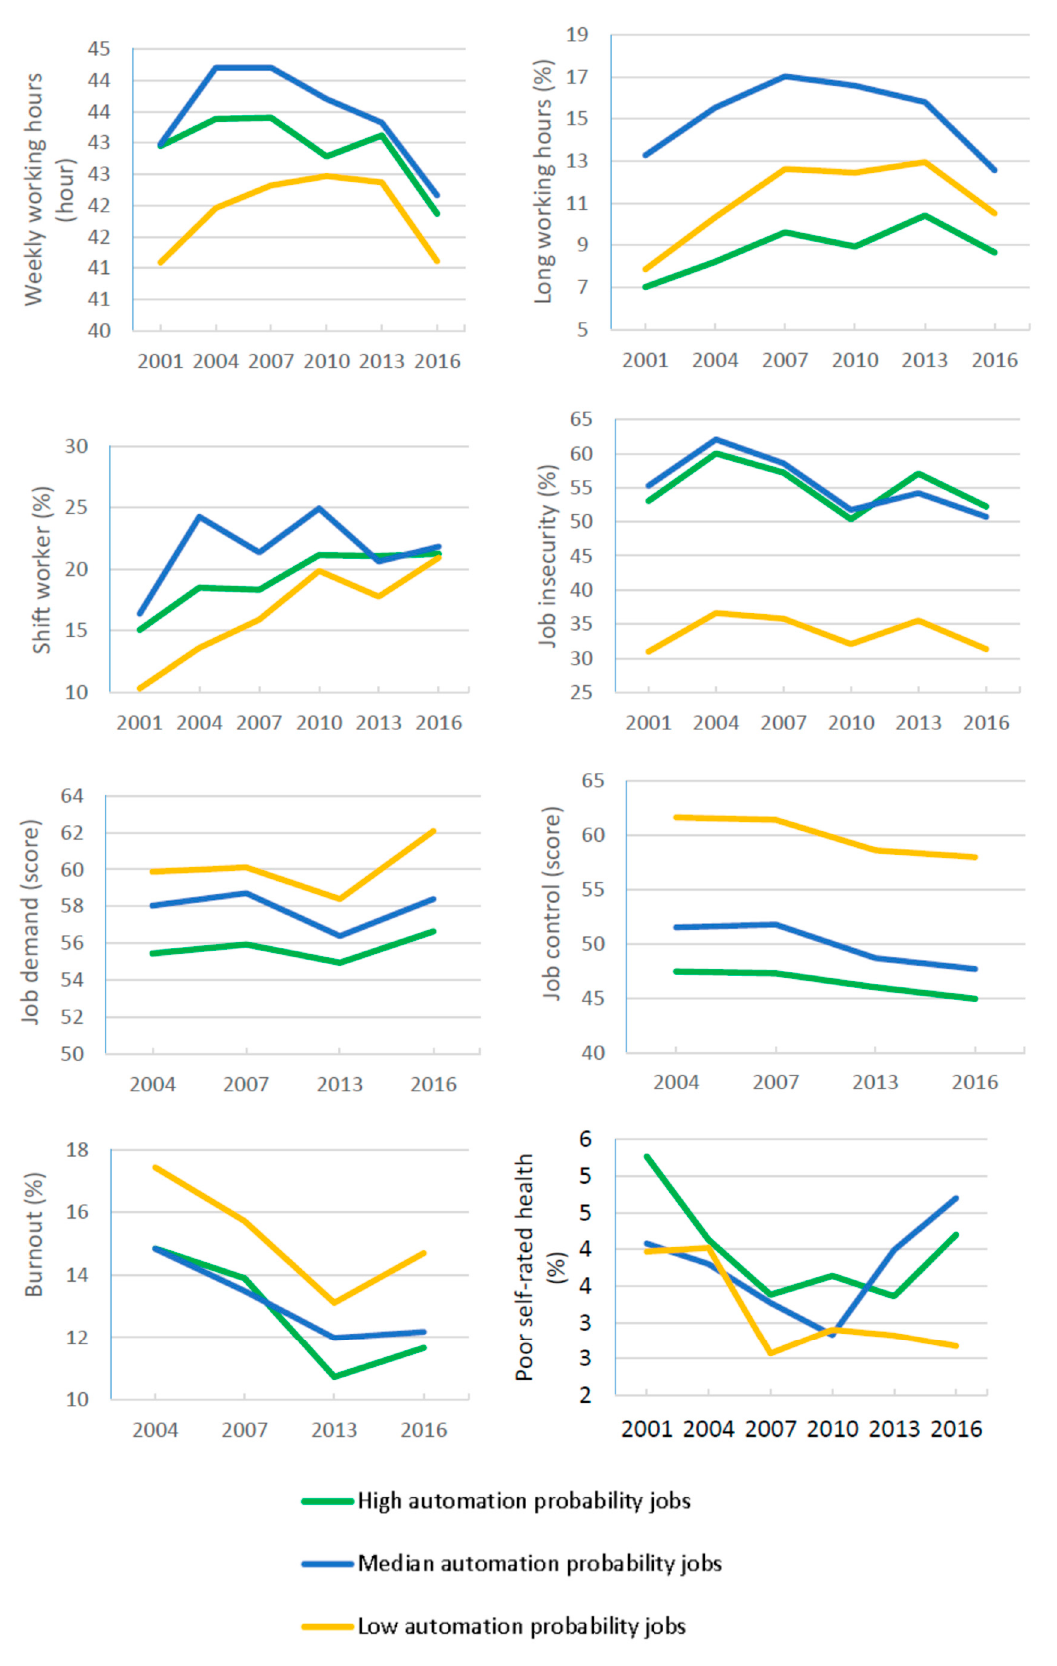
Figure 2. Temporal trends in work conditions, poor self-rated health, and burnout stratified by three levels of job automation probability.